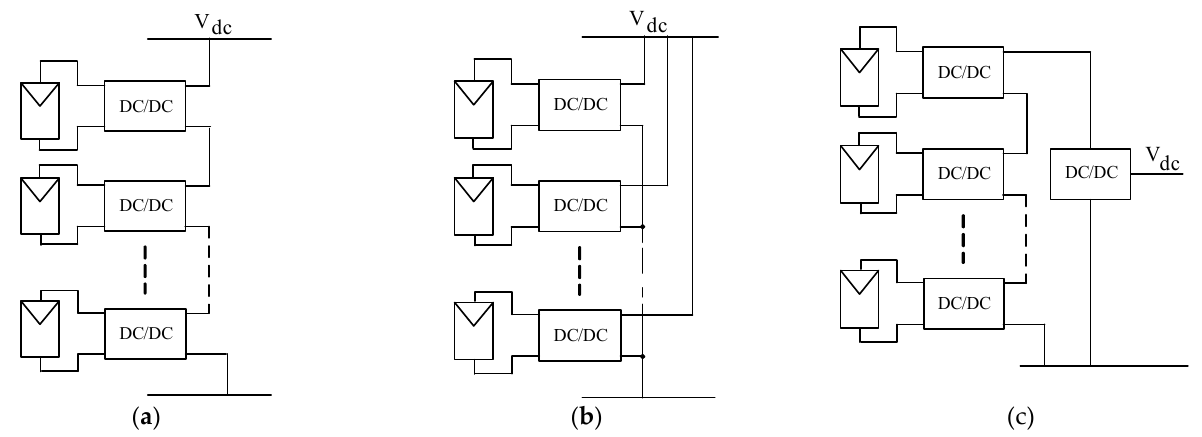
Figure 26. Basic interconnection patterns of dc optimizers: series ( a ); parallel ( b ); two-stage approach ( c ).